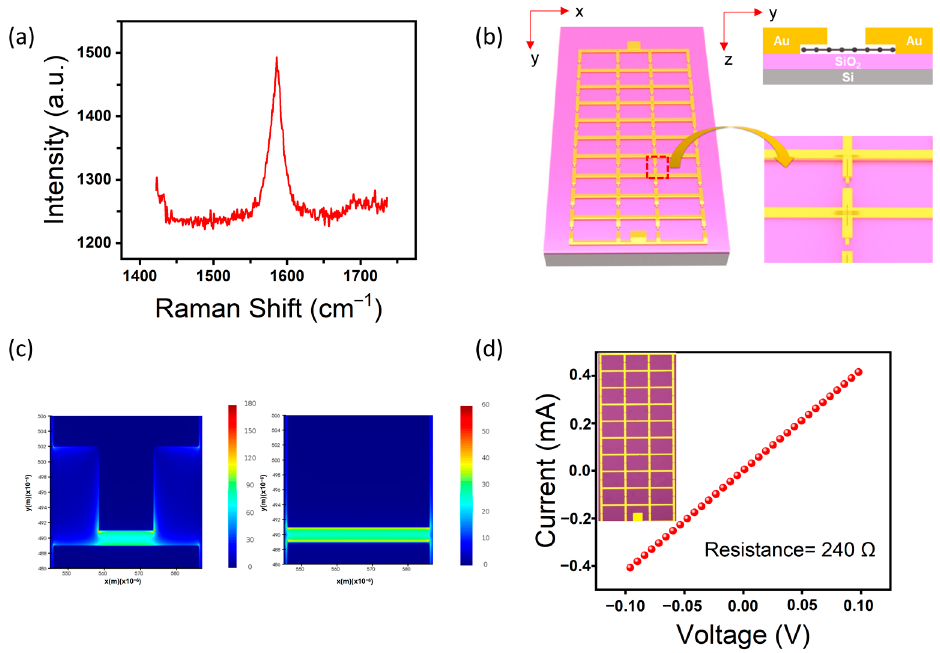
Figure 1. ( a ) The Raman spectroscopy characterization of graphene. ( b ) Schematic diagram of the structure for the grid antenna, and the illustration on the right is enlarged along the red dotted line. ( c ) By using FDTD simulation, the field distribution along channel of asymmetrical (left) and symmetrical (right) structures. ( d ) The current–voltage curve of the device is shown, and the insert presents the optical microphotography of the THz